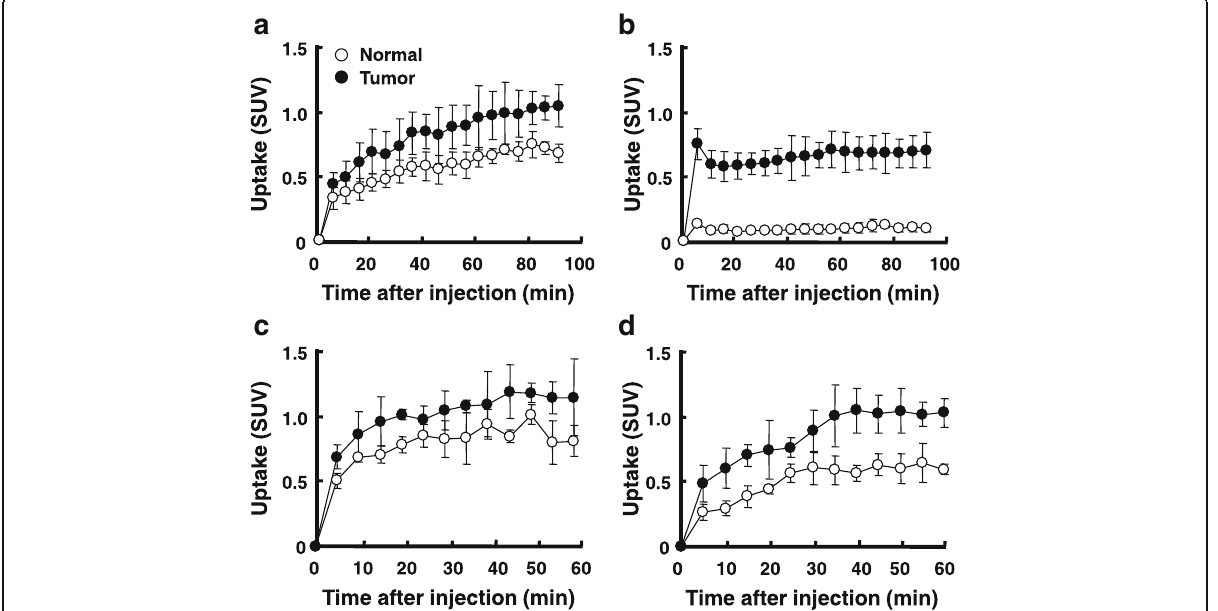
Fig. 3 Time activity curves (TACs) of L- and D- 18 F-FBPA ( a , b ) and L- and D- 11 C-CMT ( c , d ) in C6 glioma-bearing rat brains. PET scans were performed as shown in the legend of Fig. 2, dynamic images were reconstructed every 5 min for TACs, VOIs were set on the glioma region in the right brain hemisphere and normal region in the contralateral left hemisphere, and TACs were obtained in each region as